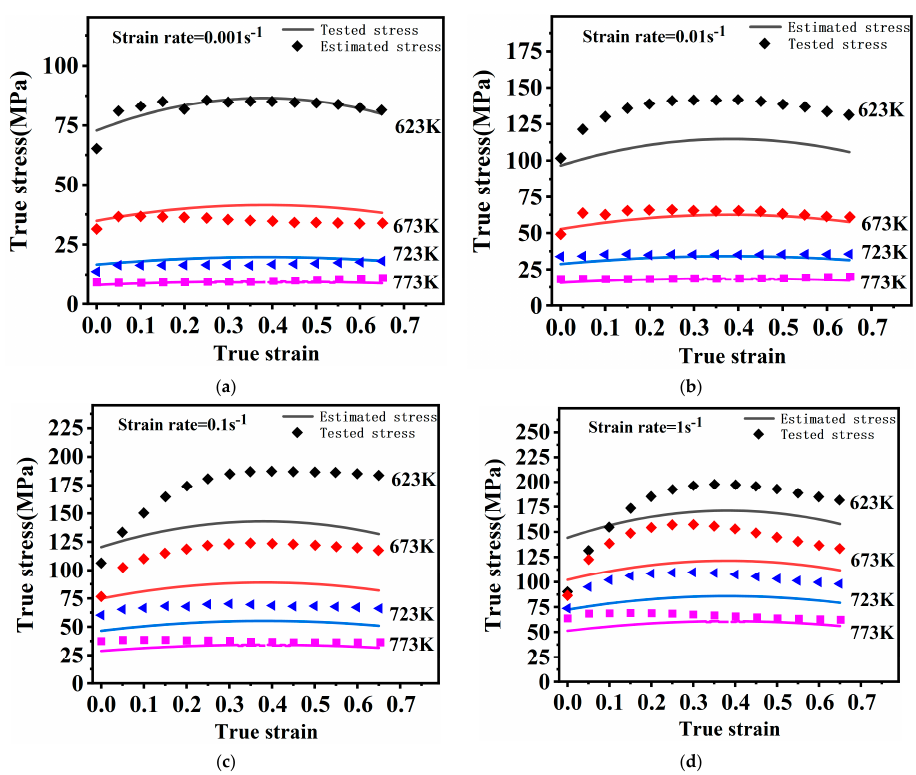
Figure 8. The correlation of k and ln ( )/(ln 0